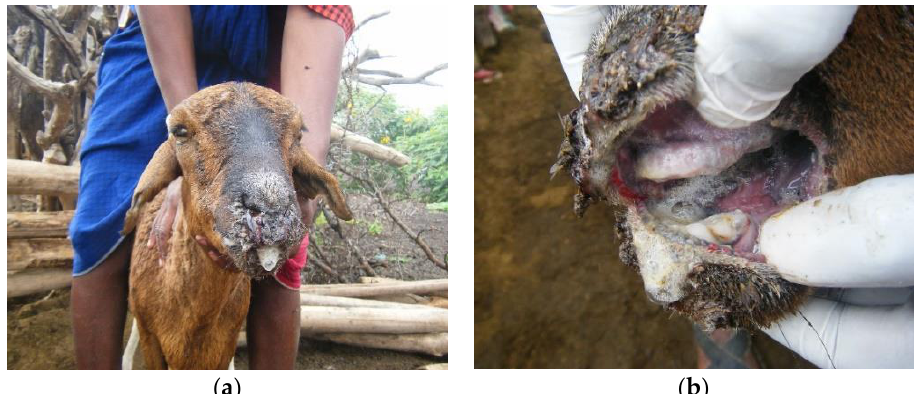
Figure 6. ( a ) A 4-year-old sheep with nasal discharge, frothy salivation, swollen and ulcerated muzzle; ( b ) extensive ulceration of lips and buccal cavity, and diarrhoea. This sheep was peste des petits ruminants virus (PPRV) real-time reverse transcription polymerase chain reaction (RT-qPCR) negative and bluetongue virus (BTV) RT-qPCR positive. It was in Flock 9 (confirmed PPRV and BTV infected) in Olorien-Magaiduru, in which two other sheep were PPRV RT-qPCR